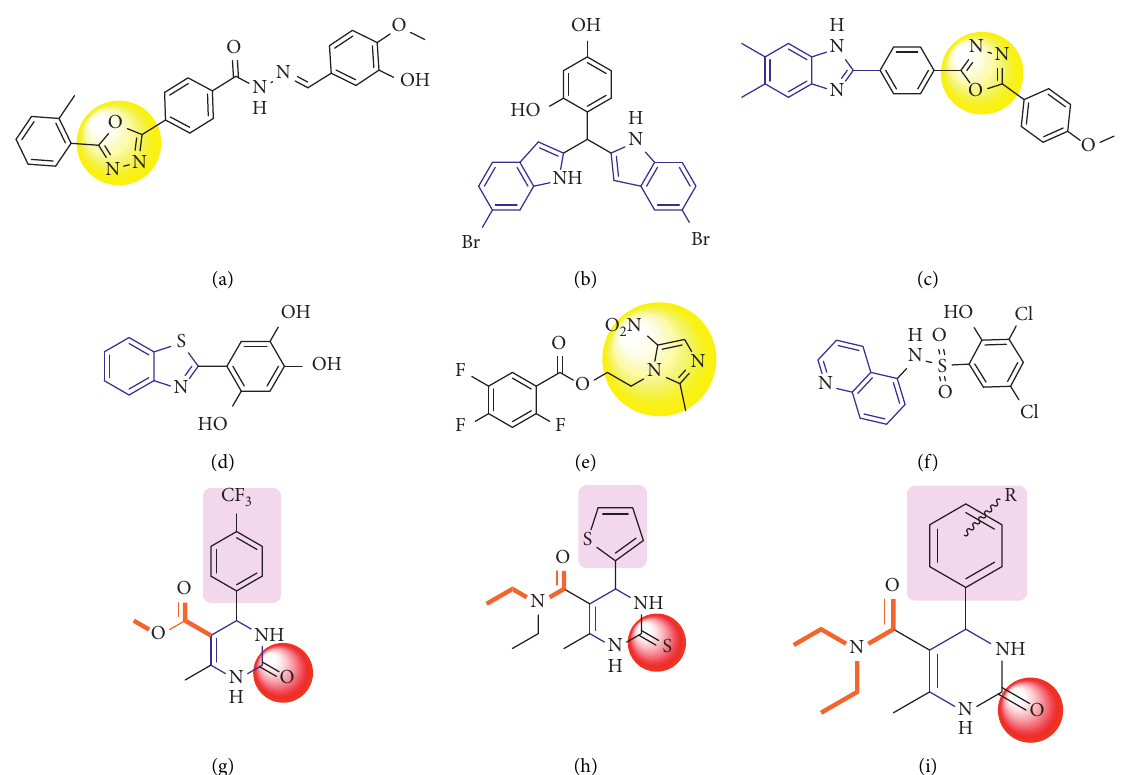
� 7.17 ± 0.30 μ M, (b) IC 50